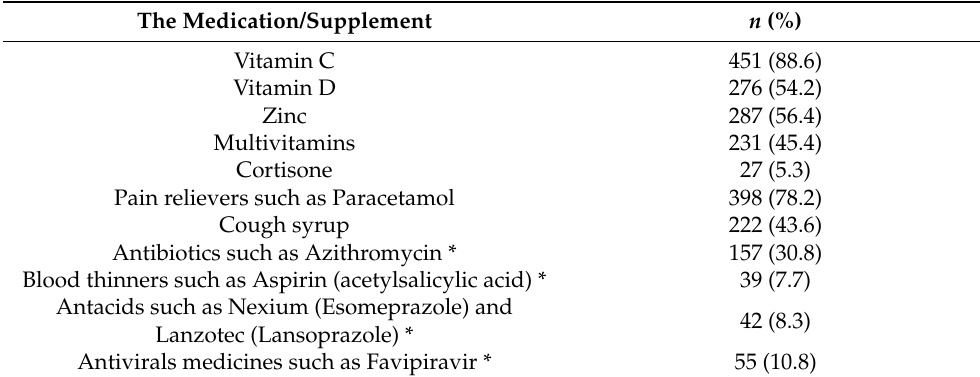
Table 3. The medication/supplement used by the study participants ( n = 509) during their COVID-19